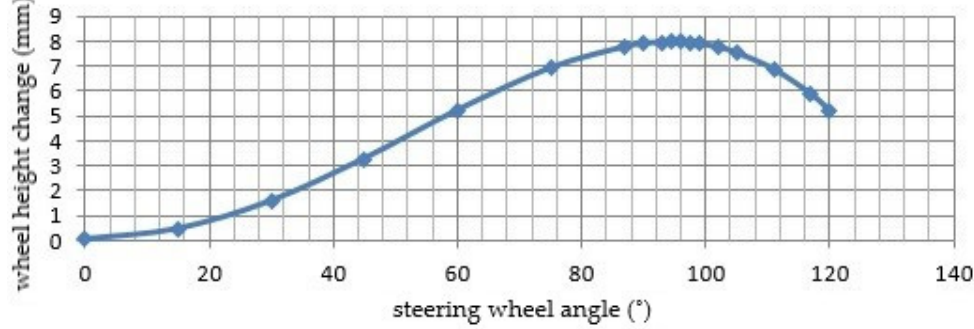
Figure 3. Graph of dependence of front wheel height on steering wheel angle.